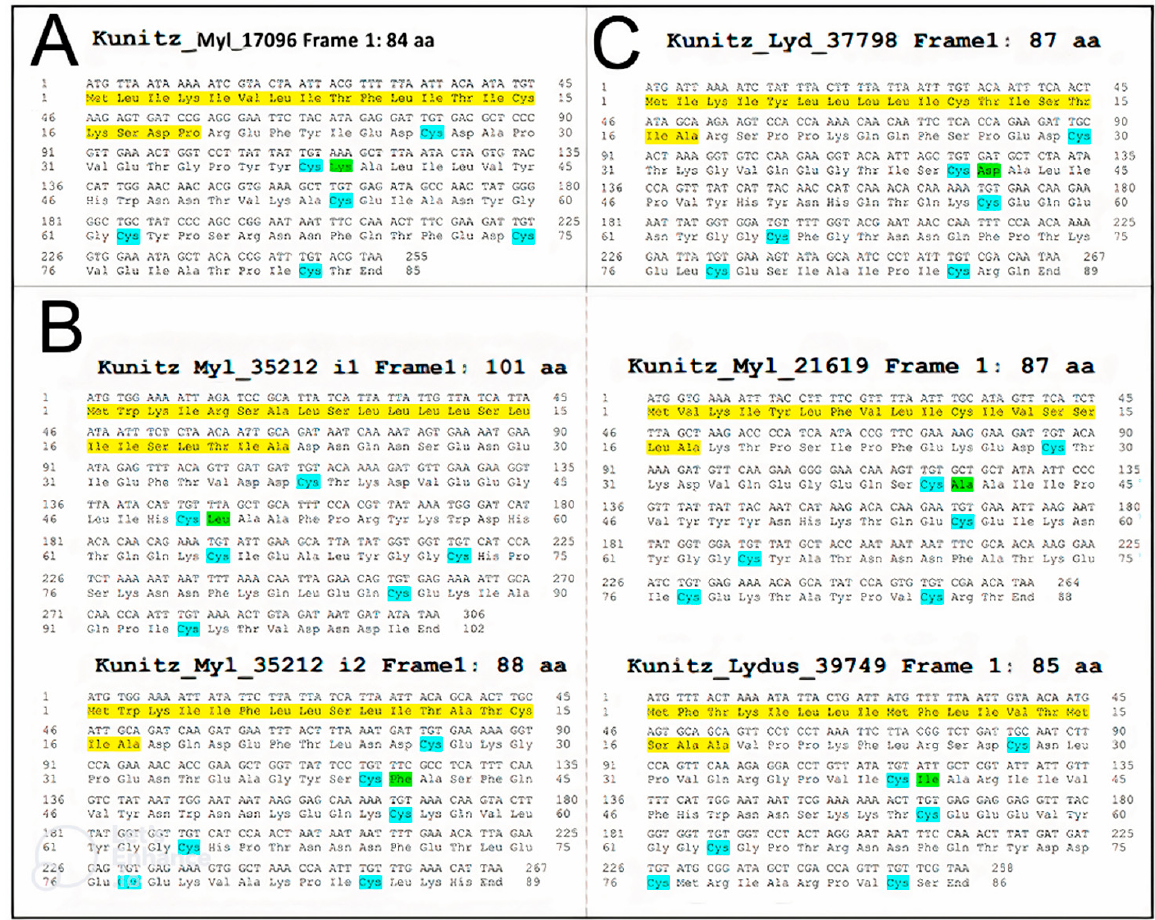
Figure 5. Transcript and protein sequences from sequenced clones. ( A ) Basic P1 residue. ( B ) Nonpolar P1 residues. ( C ) Acidic P1 residue. Yellow, leader sequence; blue, cysteine residues involved in disulphide bridges; green, P1 residue.